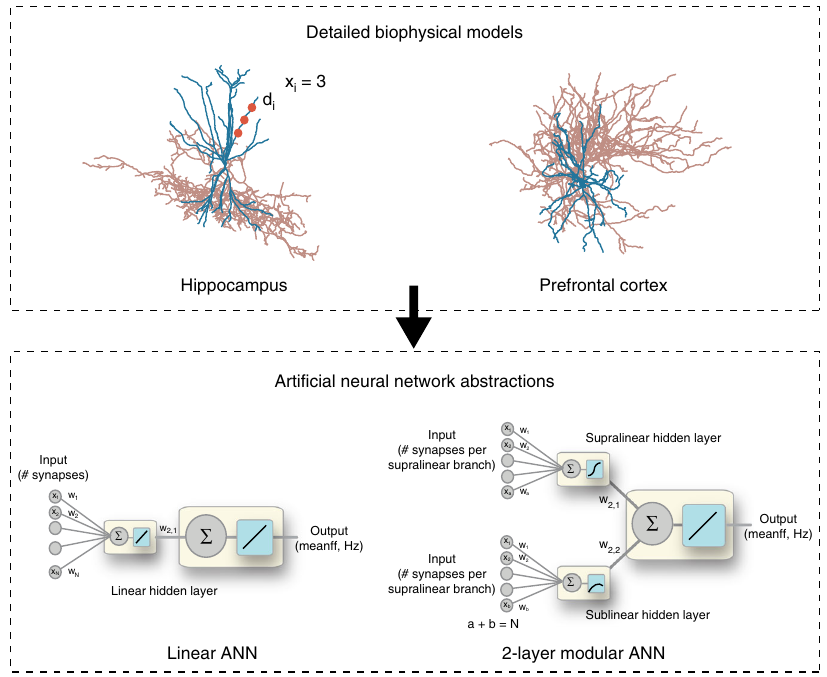
Fig. 5 Reduction of multi-compartmental models into ANN abstractions. Two types of abstractions are examined: (a) a Linear ANN, in which the input from all dendrites ( x i = number of synapses in dendrite i, N = number of dendrites) is linearly combined at the cell body and (b) a two-layer modular ANN, in which the input is fed into two parallel, separated hidden layers. The supralinear-layer receives the number of inputs landing onto supralinear branches ( a = number of supralinear dendrites) while the sublinear layer receives the number of inputs landing onto sublinear dendrites ( b = number of sublinear dendrites). Neurons in both hidden layers are equipped with nonlinear transfer functions, a logistic sigmoid in the supralinear layer and a sublinear function in the sublinear layer. The somatic transfer functions of both ANNs are